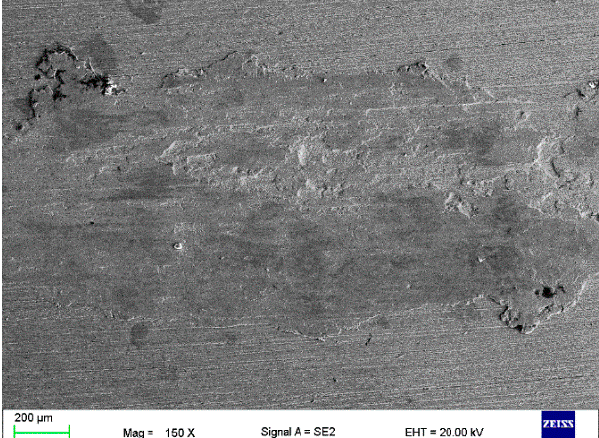
Figure 16. Wear track ( a , b ) of the tested CrAl v = 0.8 mm 3 /min layer and ( c ) wear debris.